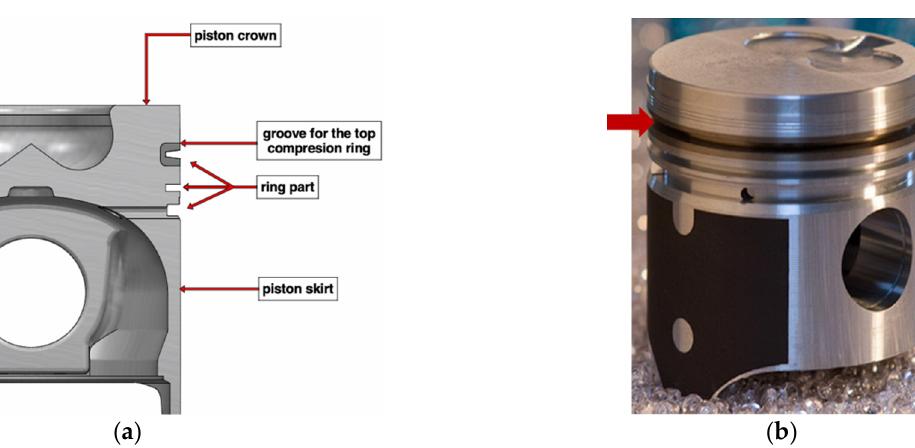
Figure 3. Piston for diesel engines with a cast iron insert: ( a ) Scheme of the piston cross-section divided into key components and ( b ) View of the piston; the arrow marks the area reinforced with a cast iron insert [37].